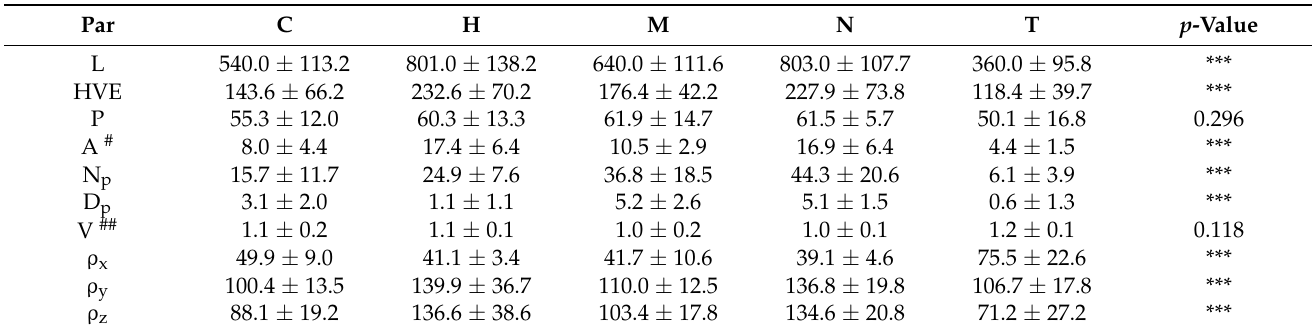
Table 1. Univariate statistical analysis performed through one-way Kruskal Wallis plus post-hoc for all the variables.